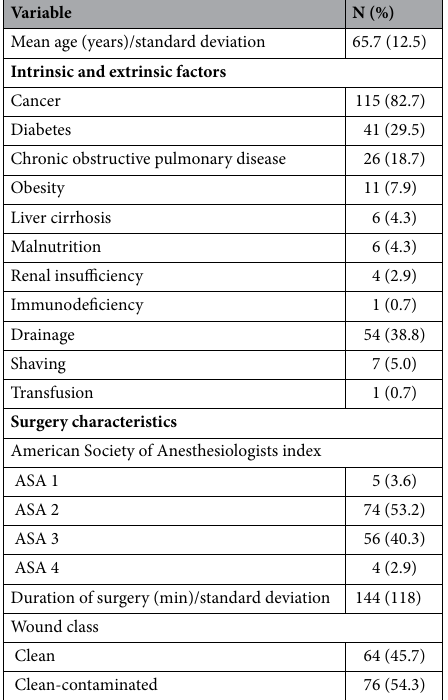
Table 3. Demographic, clinical and surgical characteristics of patients undergoing head and neck surgery (N =